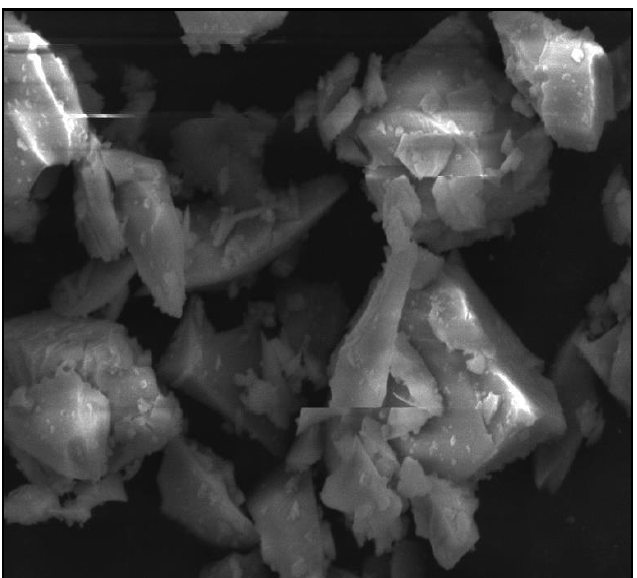
Fig. 2. SEM of GGBS